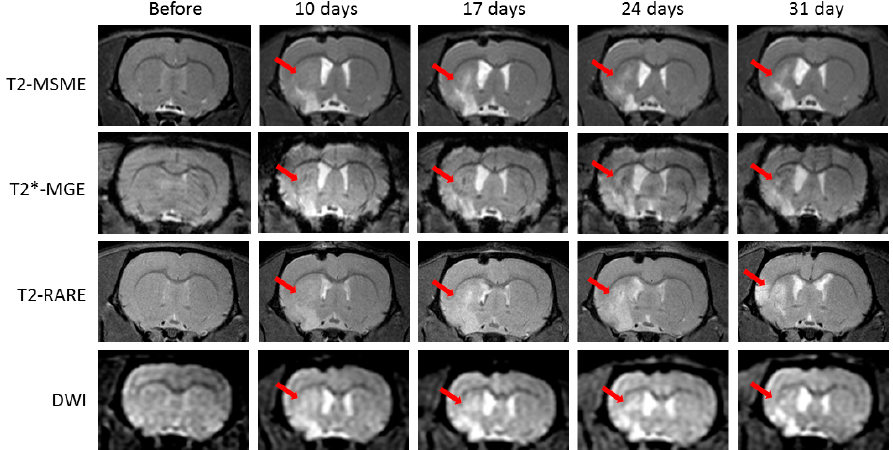
Figure 1. Example of the ischemic lesion evolution detected in the rat brain in vivo before middle-cerebral-artery occlusion (MCAO) and on days 10, 17, 24, and 31 after surgery and days 7, 14, 21, and 28 after phosphate-buffered saline (PBS) injection on T2-weighted multislice multiecho (T2-MSME), T2*-weighted multiple gradient echo (T2*-MGE), T2-weighted turbo rapid acquisition with relaxation enhancement (T2 TURBO RARE), and diffusion-weighted images (DWI). Red arrows point to the ischemic lesion area.